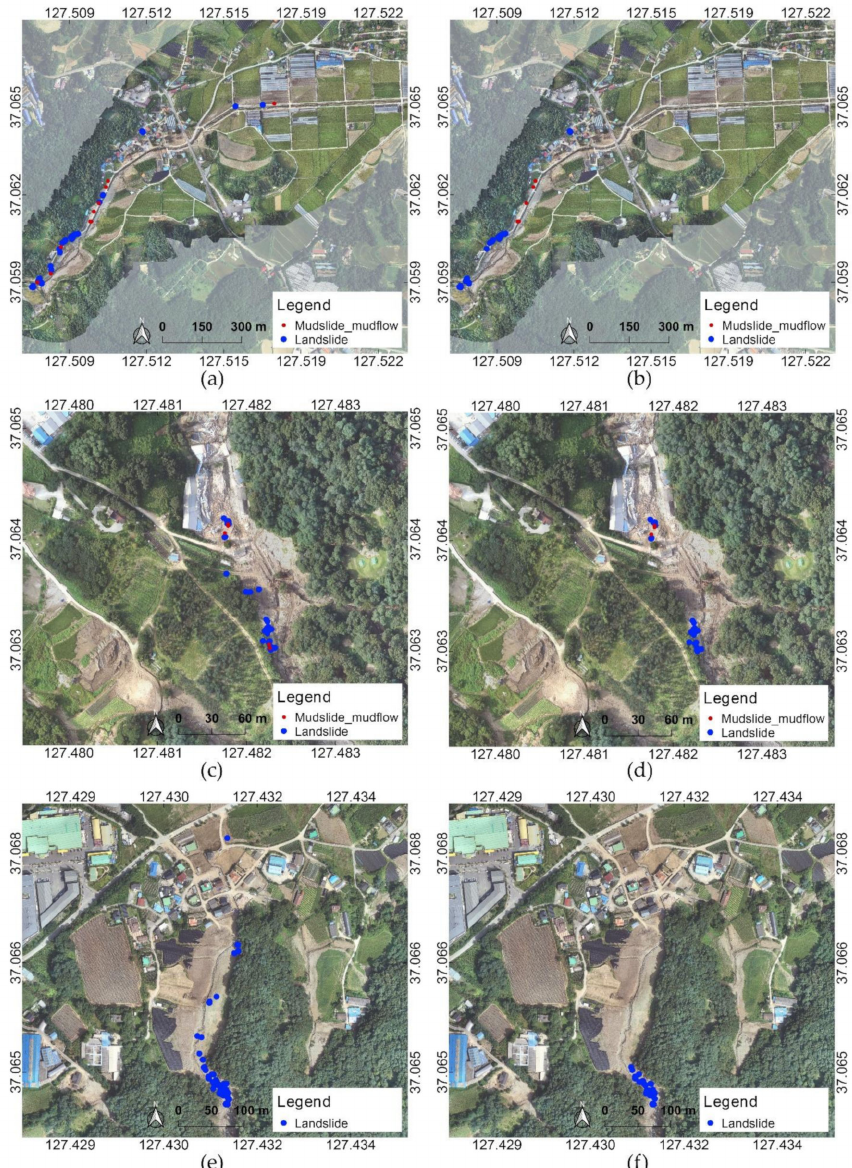
Figure 10. Distribution of results based on analysis of 24–25 August dataset: ( a ) results without hotspot analysis in Yul, ( b ) results with hotspot analysis in Yul, ( c ) results without hotspot analysis in Iljuk, ( d ) results with hotspot analysis in Iljuk, ( e ) results without hotspot analysis in Juksan, and ( f ) results with hotspot analysis in Juksan. The coordinates refer to WGS84 (EPSG: